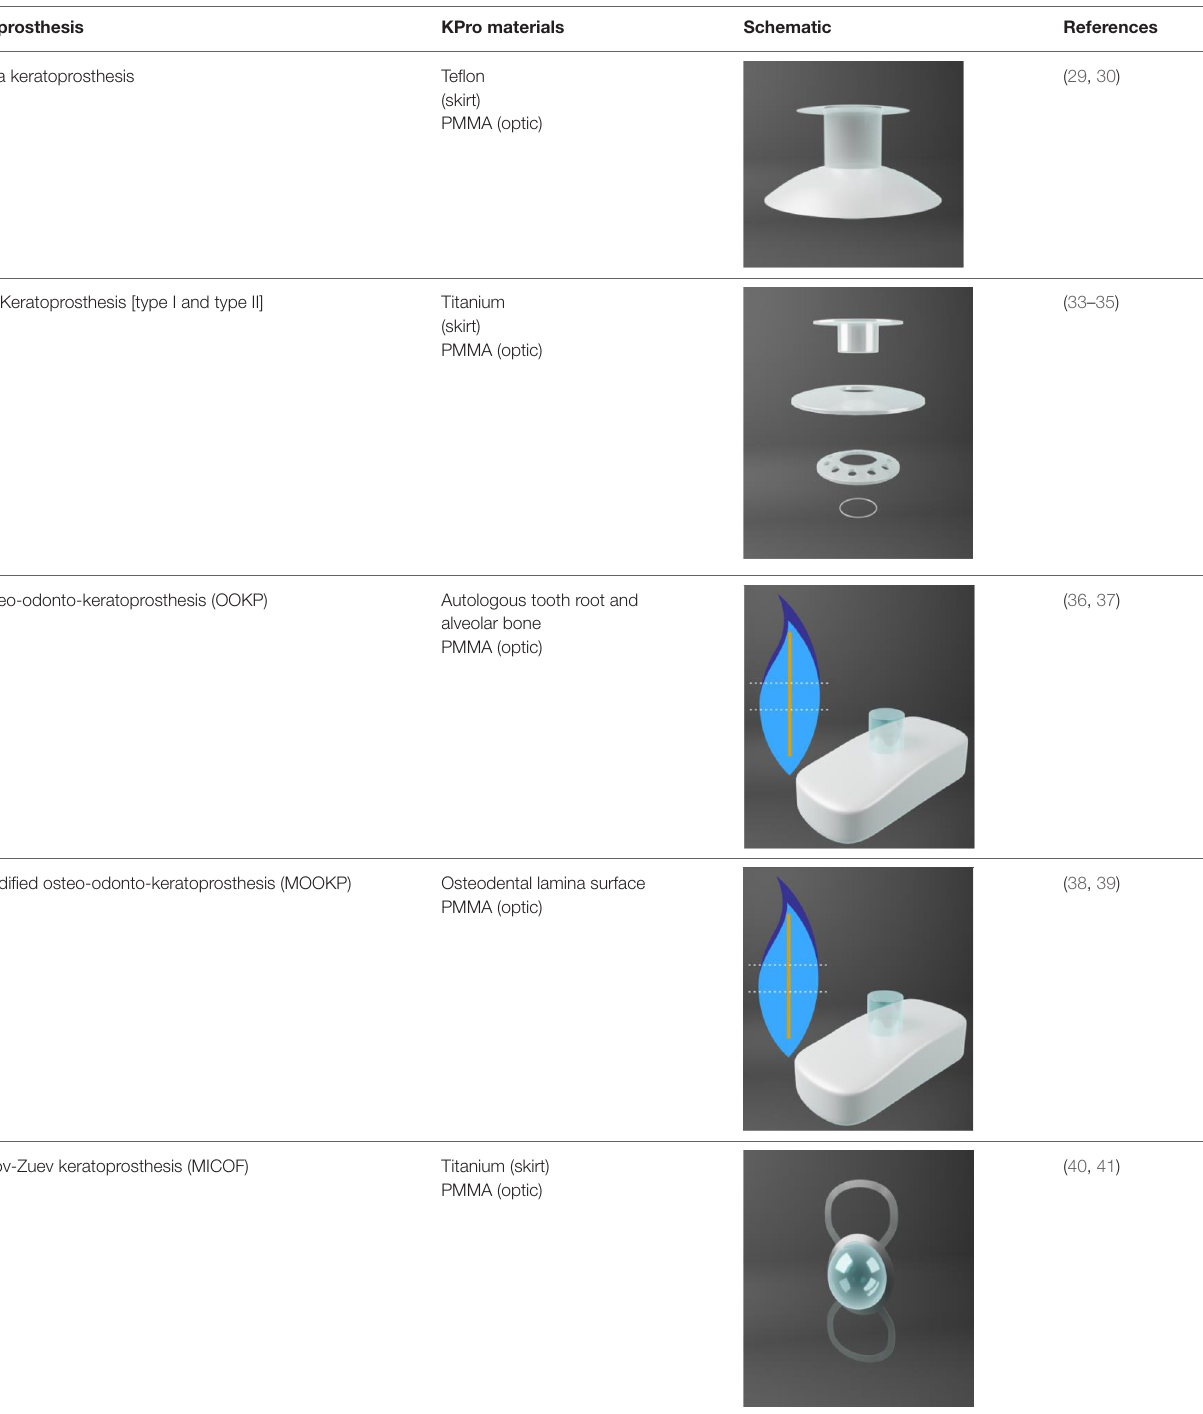
TABLE 2 | Description of commercial Hard-Keratoprostheses with skirts based on resilient materials, and transparent optic cylinders composed of polymethyl methacrylate